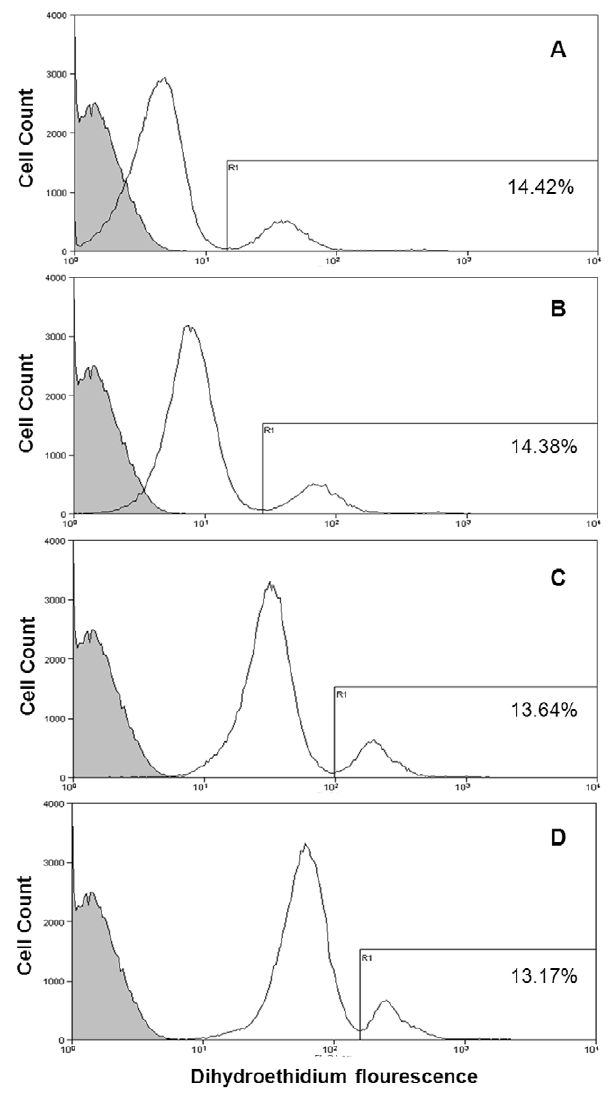
Figure 1. Ring-staged 3D7 Plasmodium falciparum culture labeled with varying concentrations of dihydroethidium. Ring- staged cultures at about 15% parasitemia, 1% hematocrit were labeled with A ) 5 m g/ml, B ) 10 m g/ml, C ) 25 m g/ml and D ) 50 m g/ml DHE for 20 min at 37 u C and each was compared to an (gray shade histogram) unstained blood control using flow cytometry. Cultures labeled with 5 m g/ml DHE showed a clear resolution between infected and uninfected erythrocytes (obtaining a parasitemia of 14.42% which corresponded to that in the Giemsa blood smear) and a low uRBC background as compared to the other concentrations. of ring and schizont iRBCs in monocytes were similar to ring iRBC uptake in macrophages.